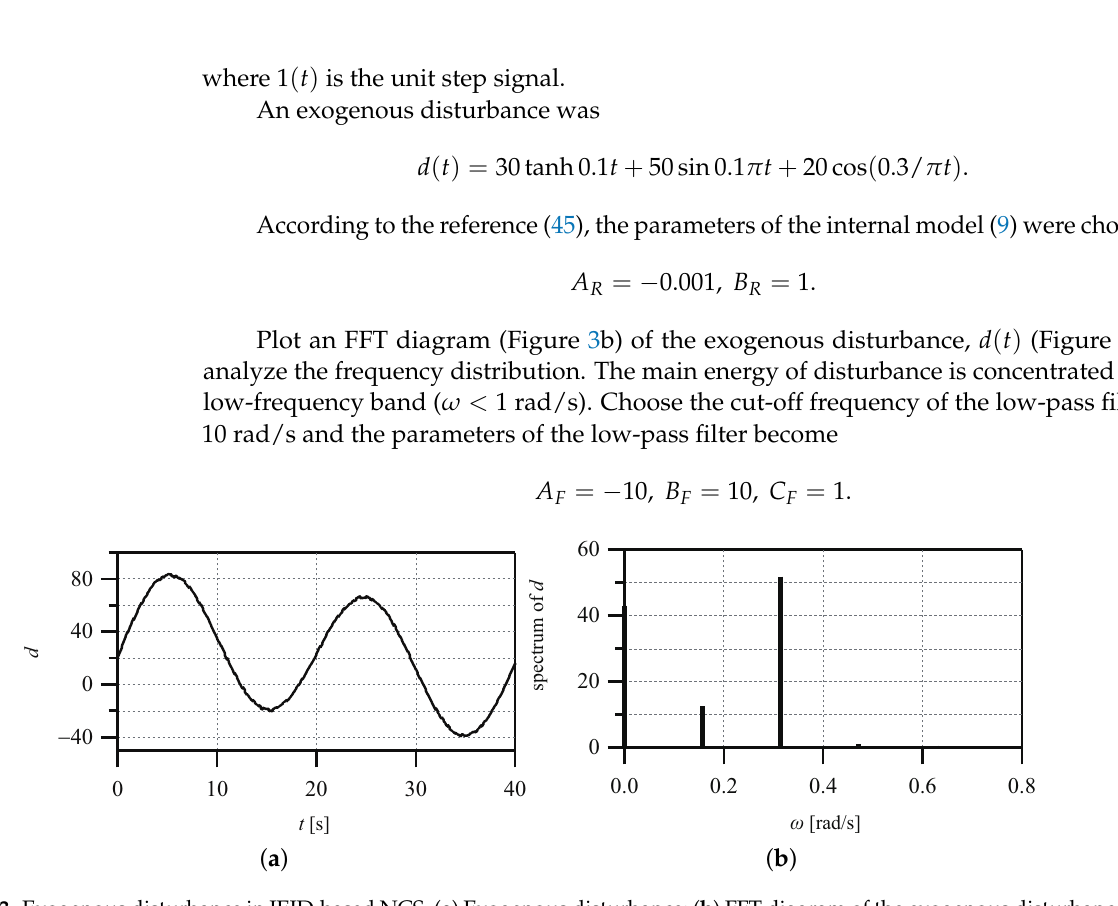
Figure 3. Exogenous disturbance in IEID-based NCS. ( a ) Exogenous disturbance; ( b ) FFT diagram of the exogenous